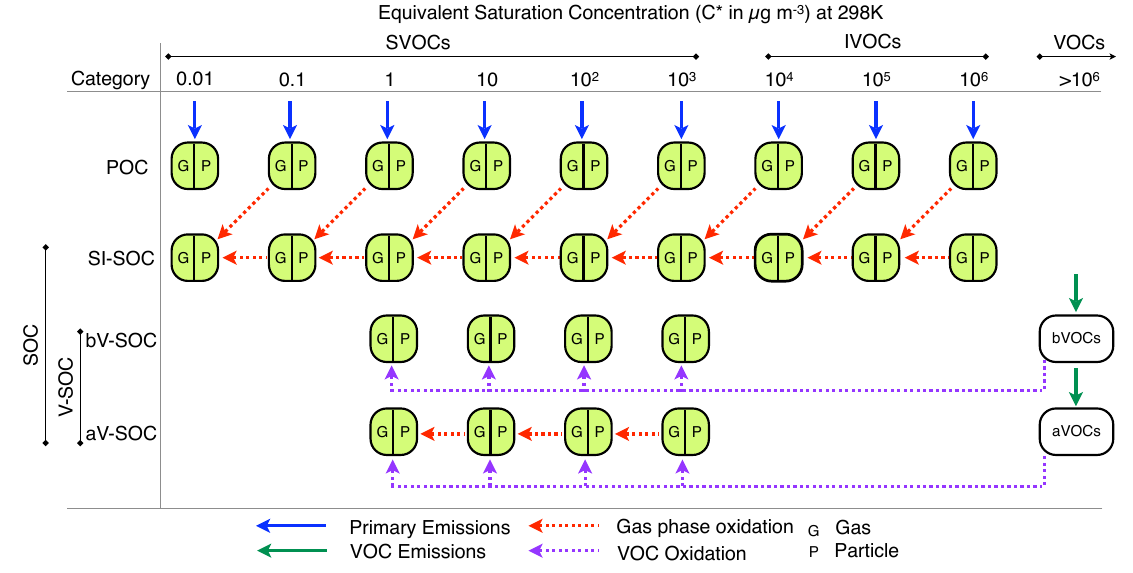
Fig. 1. Schematic for the volatility basis set (VBS) framework as used in this study. The saturation concentration spectrum is divided into semi-volatile (SVOC, C ∗ =0.01 − 10 3 µgm − 3 ) and intermediate volatility (IVOC, C ∗ =10 4 − 10 6 µgm − 3 ) organic compounds. VOCs are graphically presented with C ∗ > 10 6 . bVOCs and aVOCs are biogenic and anthropogenic VOCs respectively. See Sects. 2.1.1 and 2.1.2 for a detailed